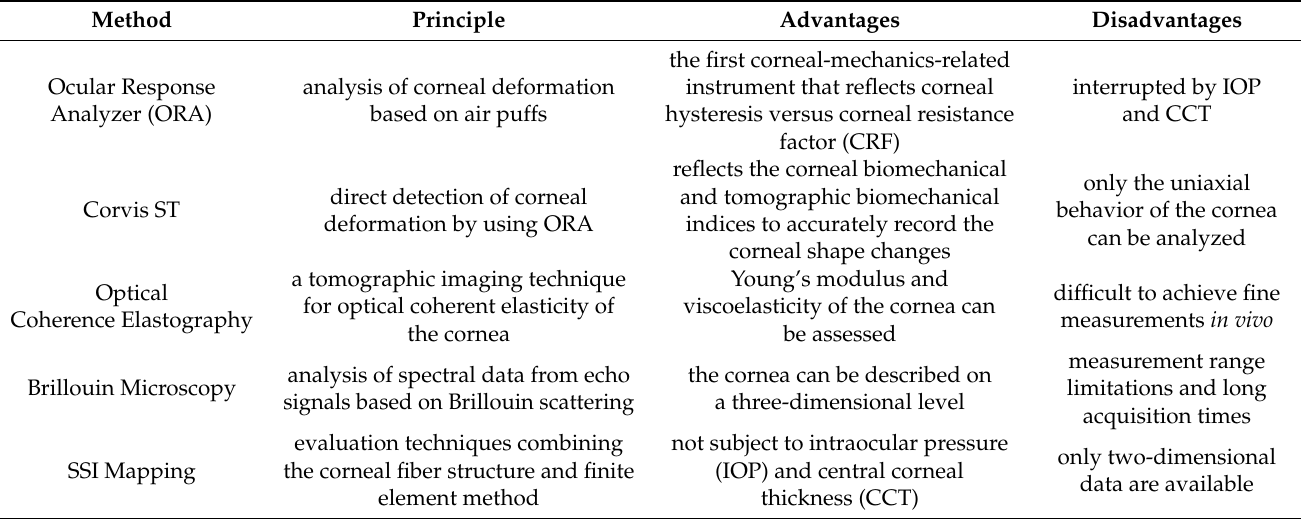
Table 1. Overview of methods used for in vivo corneal biomechanical